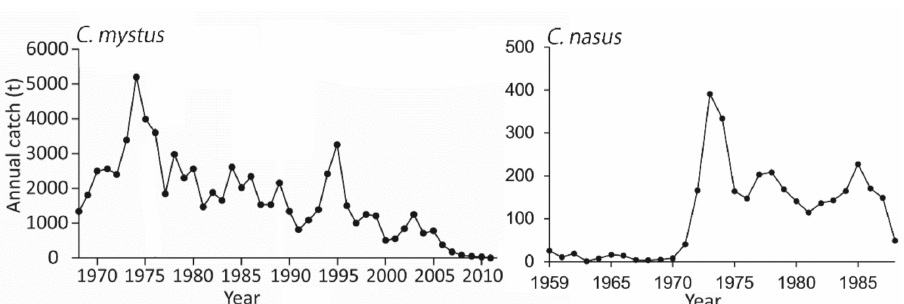
Figure 2. Annual catch of two Coilia species in the Yangtze River Estuary (Left panel: catches of C. mystus by fishing season (April–July) from 1968 to 2011 [21,26–30]; right panel: catches of C. nasus of Shanghai in the Yangtze River Estuary from 1959 to 1988